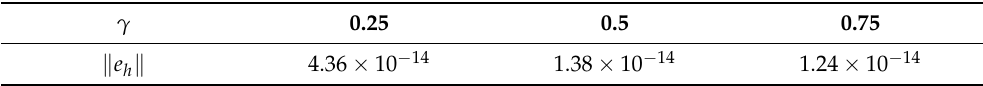
Table 1. Example 1: The infinity norm of the error (cid:107) e h (cid:107) for h = 1/8. γ 0.25 0.5 0.75 (cid:107) e (cid:107) h